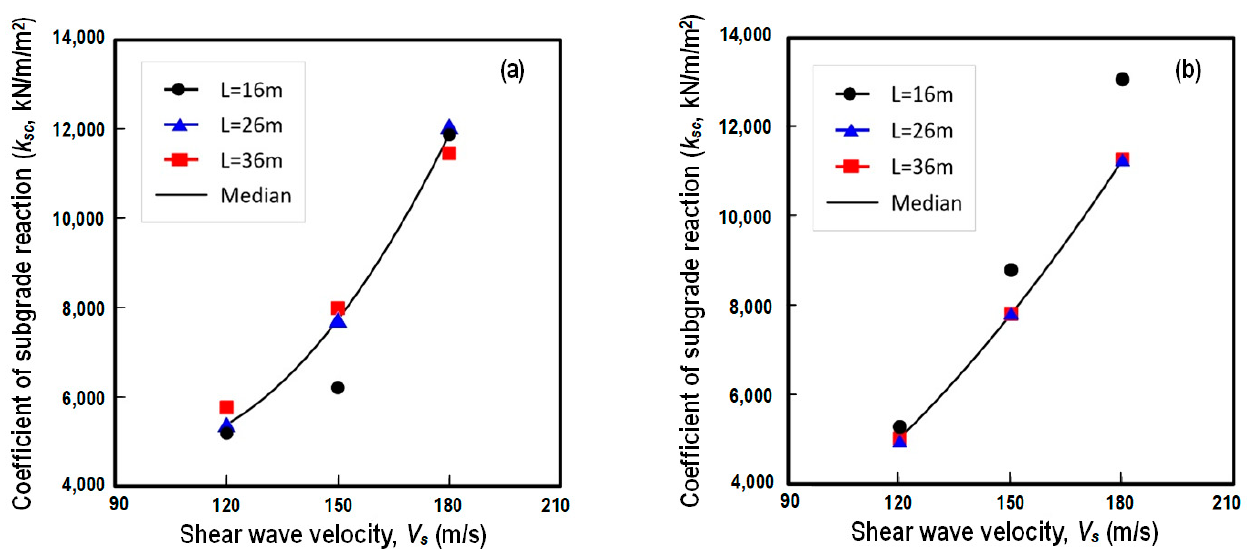
Figure 11. Interpolation function of the coefficient of subgrade reaction k sc at the foundation center based on the shear wave velocity of soils: ( a ) rafts in clays, ( b ) rafts in sands. Table 4. The suggested functions of coefficient of subgrade reaction at the center of the foundation based on shear wave velocity of the soil.